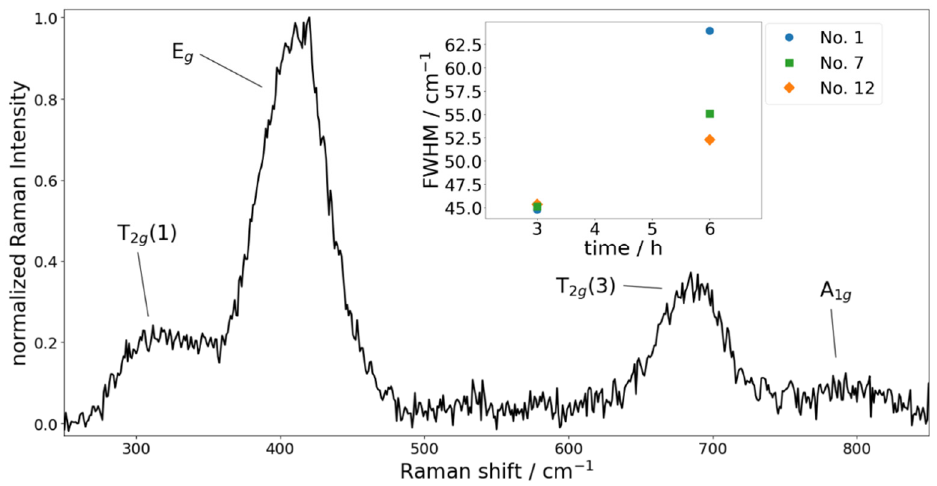
Figure 8. Exemplary Raman spectrum of the sample with mix No. 7 and a sintering time of 6 h. The four visible peaks are assigned to modes occurring in the spinel MgAl 2 O 4 . The inset shows how the peak width of the E g peak at 410 cm − 1 increases with sintering time.